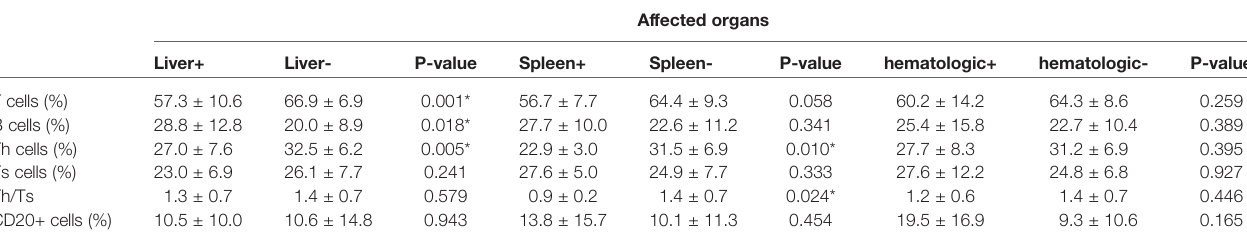
TABLE 3 | Lymphocyte subset in different affected